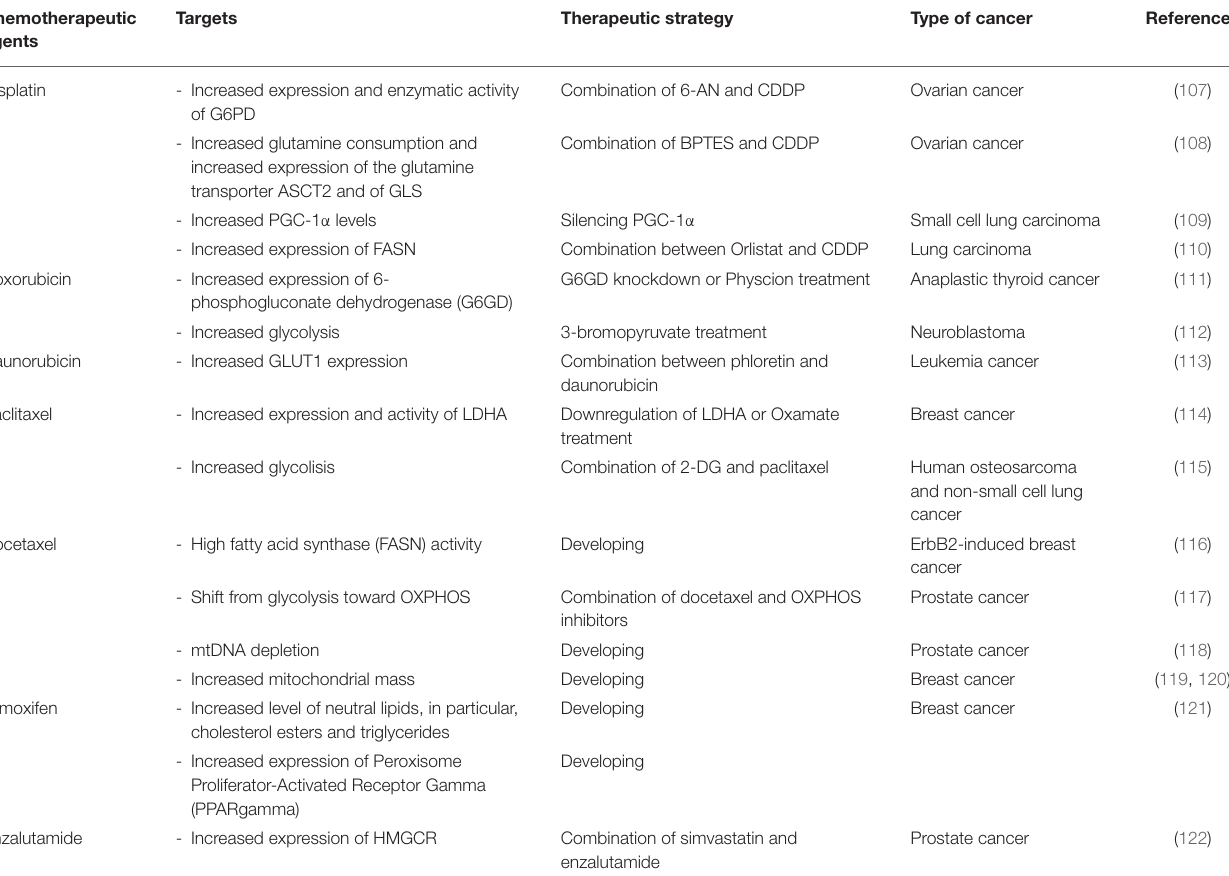
TABLE 1 | Overview of promising combination therapy of chemotherapeutic agents and metabolic modulators. Chemotherapeutic